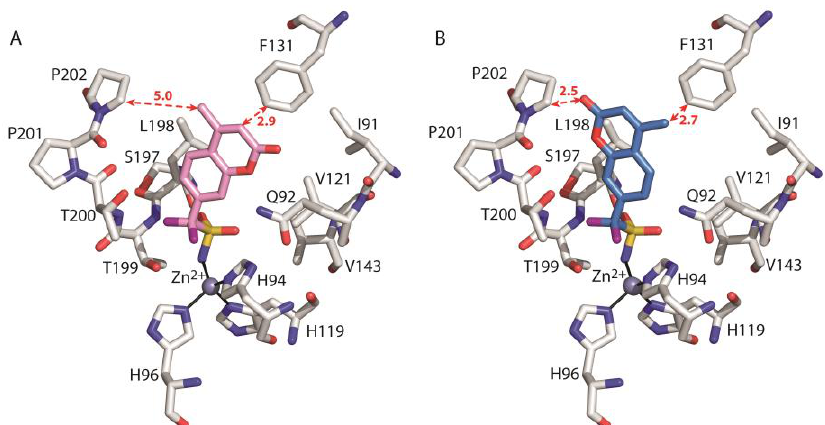
Figure 7. Detail of the active site in the crystallographic adduct hCA II/ 2 ( A ) and the model hCA II/ 2* ring ( B ). The ligand, the zinc ion, the three coordinating histidines and enzyme residues which give a major contribution to ligand binding are shown. The hydrogen atoms have been omitted for clarity. The distances (in Angstroms) between the ligand coumarin ring and the side chains of F131 and P202 are indicated with red dotted arrows.